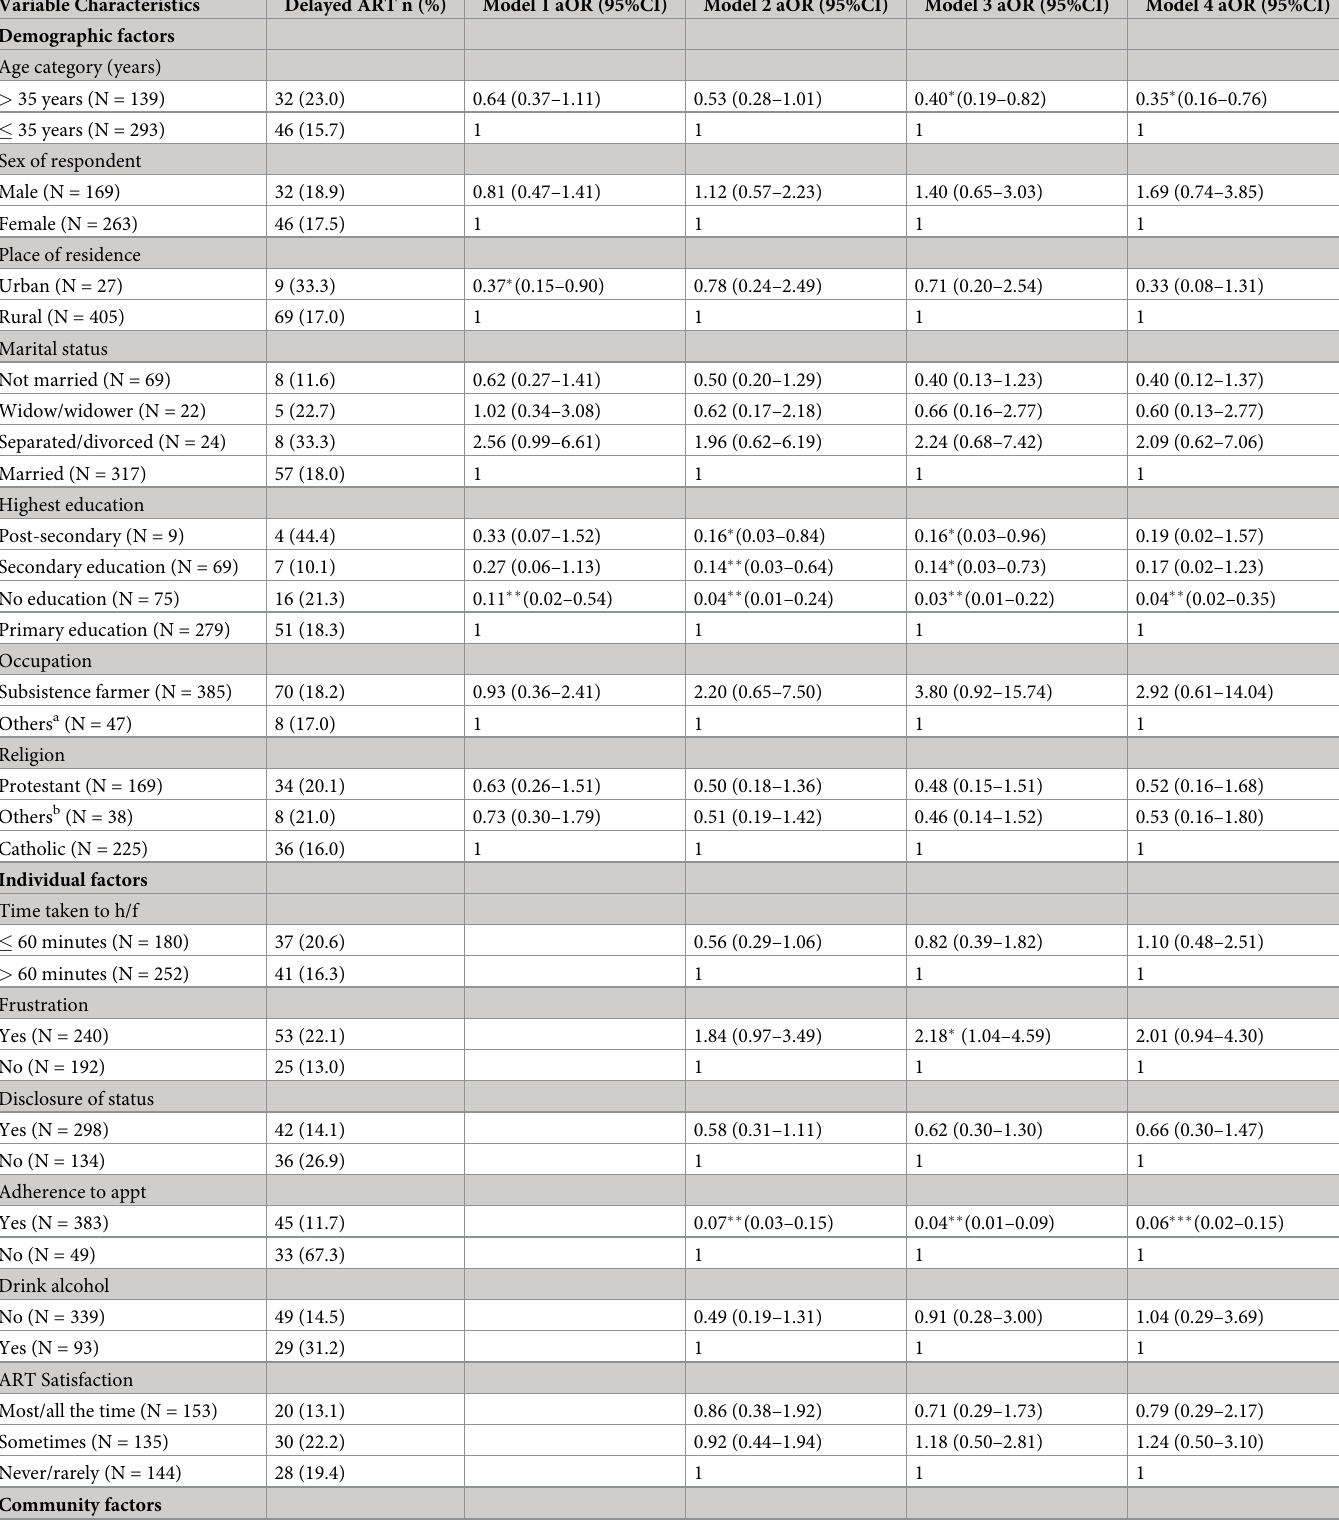
Table 4. Adjusted analysis of factors and delayed ART initiation among adults with